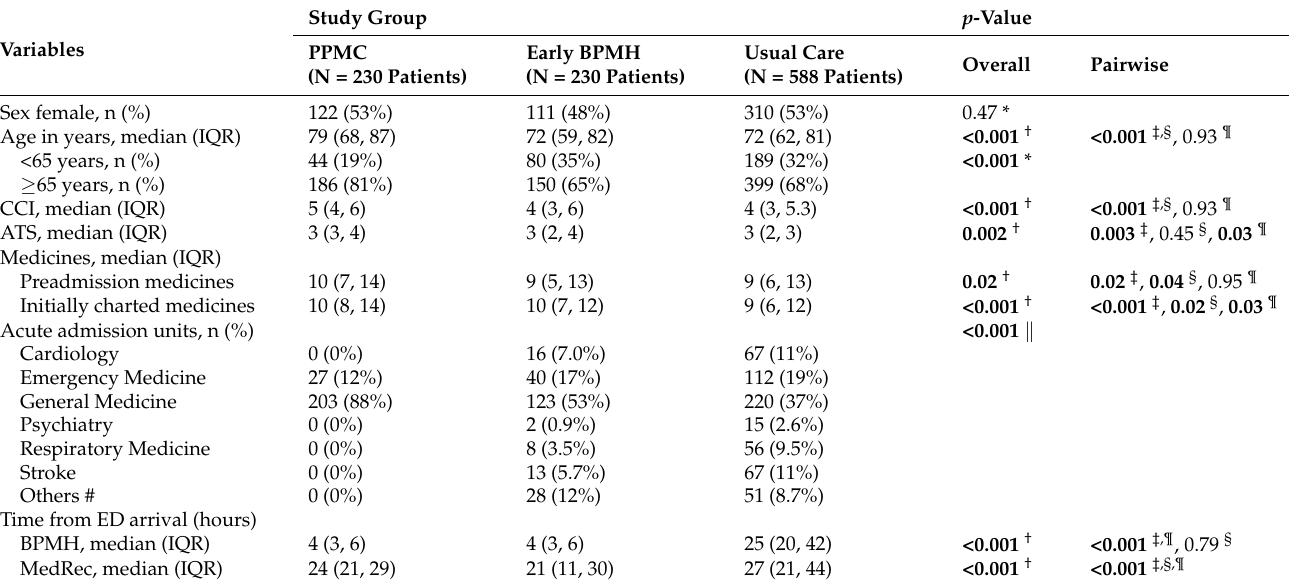
Table 1. Demographic and clinical characteristics of study